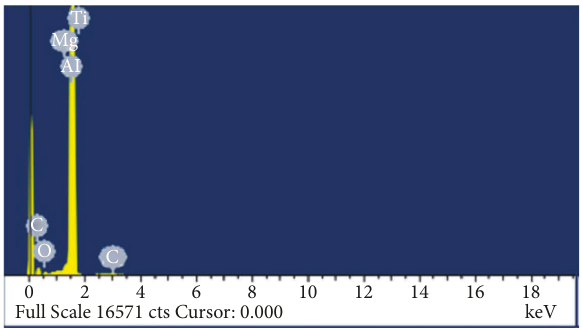
Figure 1: EDS image of AA7075 MMCs.